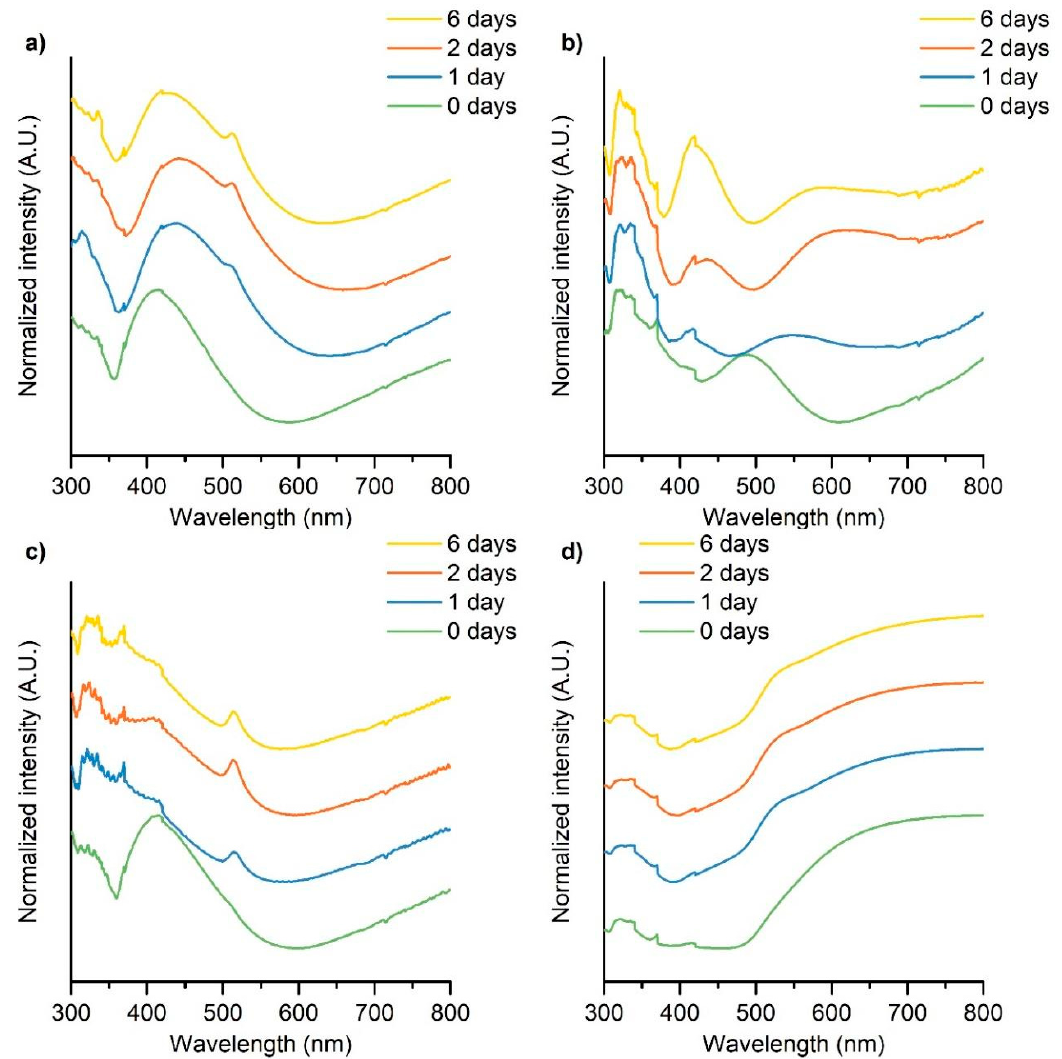
Figure 5. UV–Vis spectra in reflected light as a function of the time of exposure: ( a ) silica glass, ( b ) ITO, ( c ) soda-lime glass, and ( d ) gold.